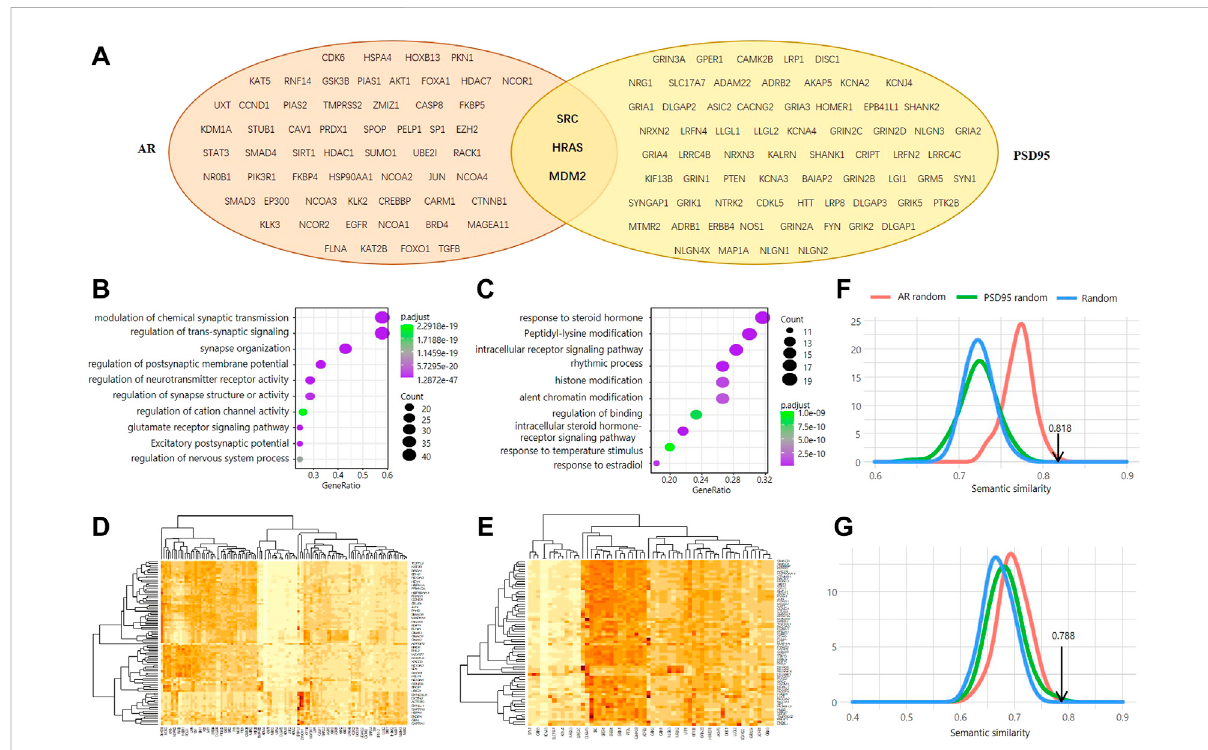
FIGURE 1 Genomic investigation of theassociation betweenAR and PSD95. (A) Venn diagram of the interactors between AR and PSD95. (B,C) Functional enrichment analysis of the PSD95 interactors (B) and AR interactors (C) . (D,E) Heatmap showing the semantic similarity between AR interactors and PSD95 interactors. Two thresholds of interaction con fi dence score, 0.9 (D) and 0.95 (E) , were used, respectively. (F,G) Distribution of the simulated SS scores calculated using wang. Three simulation methods were used and colored in red, green, and blue, respectively. Two thresholds of interaction con fi dence score, 0.9 (F) and 0.95 (G) , were used,